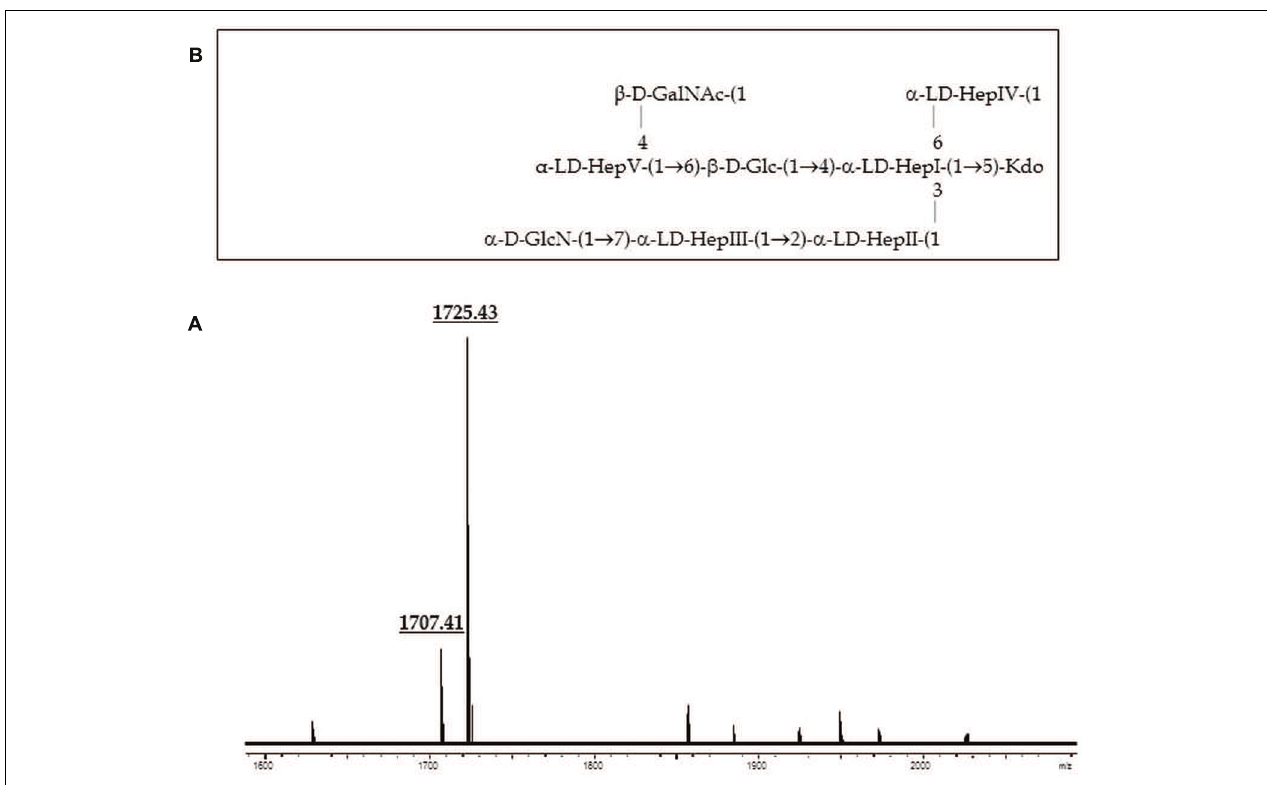
FIGURE 5 | (A) Positive-ion MALDI-TOF of purified LPS core from A. salmonicida subspecies achromogenes strain CECT4238. (B) Presumptive LPS-core structure of the same strain according to the previously published A. salmonicida A450 (Jimenez et al., 2009).